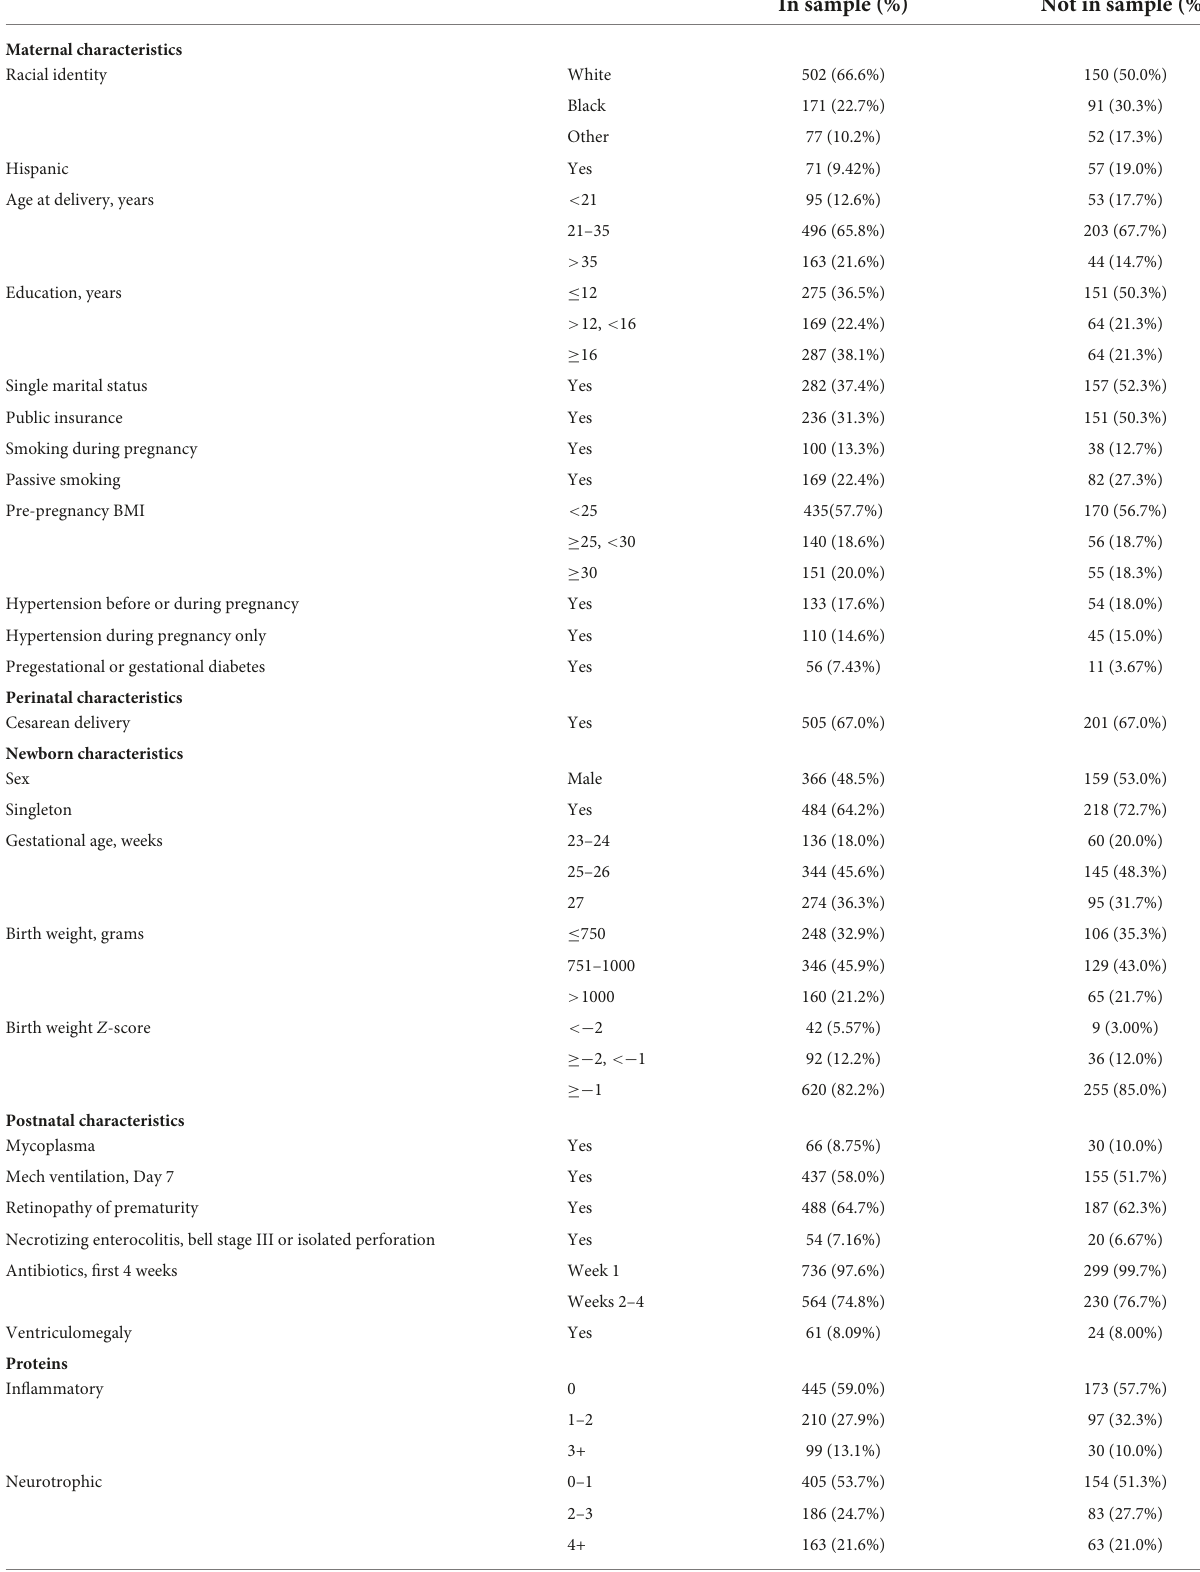
TABLE 1 Description of sample ( N =